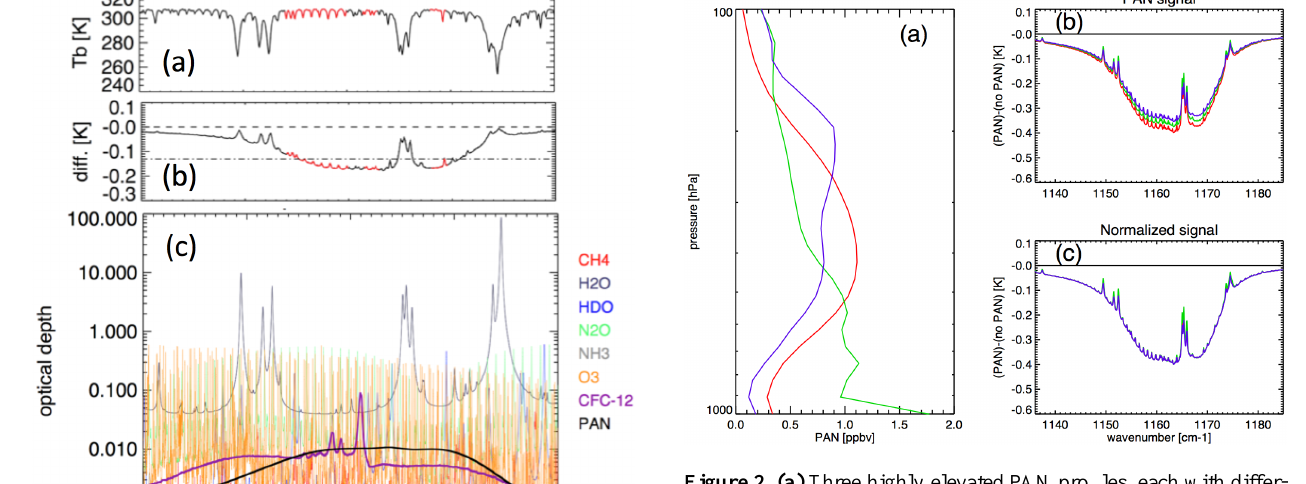
Figure 2. (a) Three highly elevated PAN profiles, each with different vertical structure. (b) Brightness temperature signals resulting from the three elevated profiles. (c) As (b), but with each the signals normalized to the greatest brightness temperature difference value shown in (b).